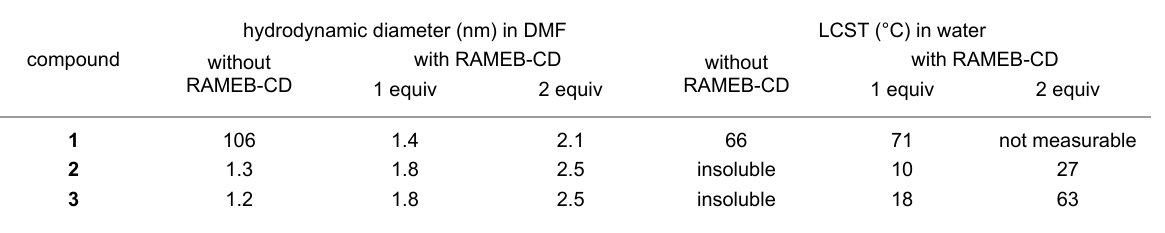
Table 1: Comparison of the hydrodynamic diameters and the LCSTs of 1 , 2 and 3 and their complexes with 1 and 2 equiv of RAMEB-CD.